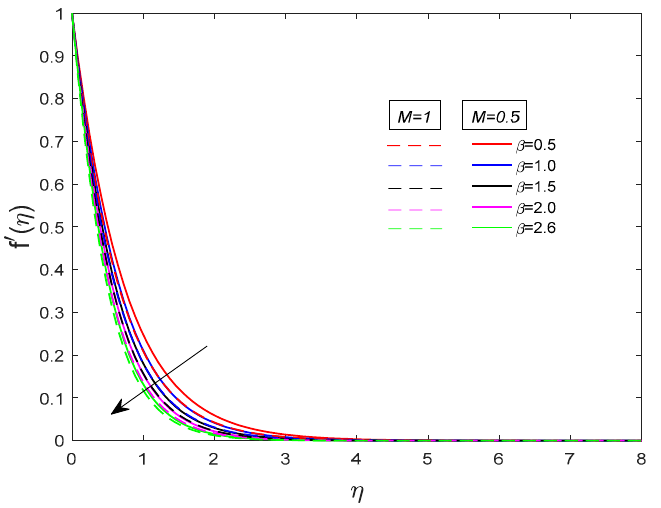
Figure 7. Effect of Maxwell fluid parameter ( β ) on axial velocity profile with Pr = Sc = 0.7, Ec = Kr = Sr = 0.1.